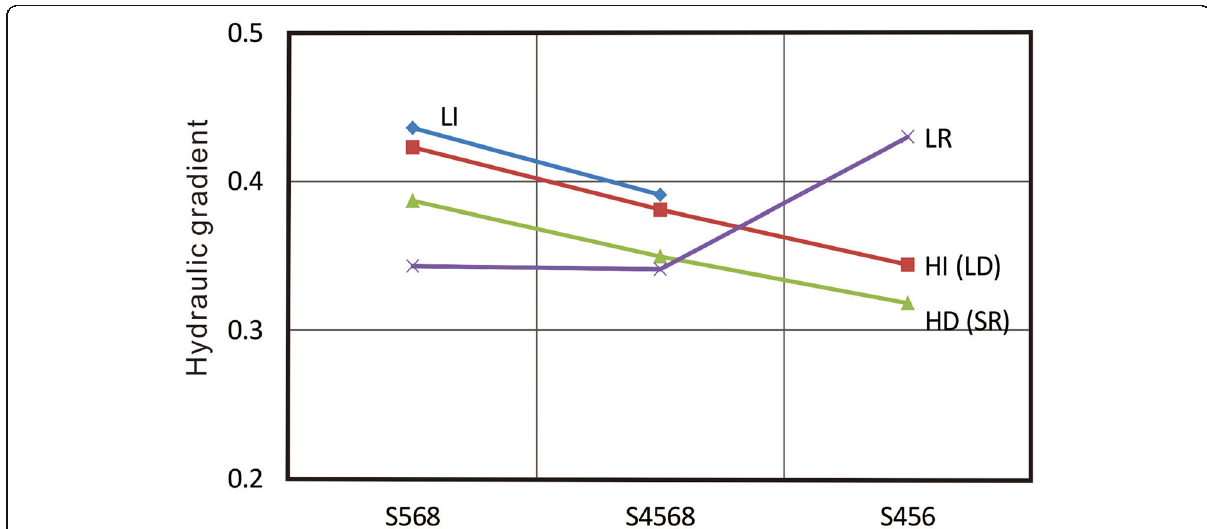
Fig. 11 Maximum hydraulic gradient for low inflow rate (LI), high inflow rate (HI), low dam (LD), high dam (HD), small reservoir (SR) and large reservoir (LR) of three samples